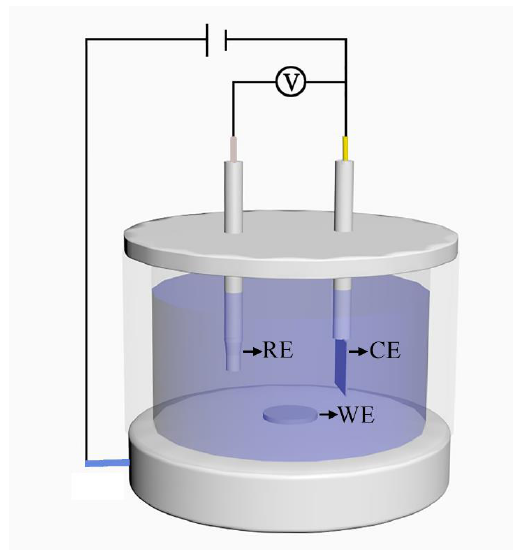
Figure 1. The schematic diagram of the three-electrode